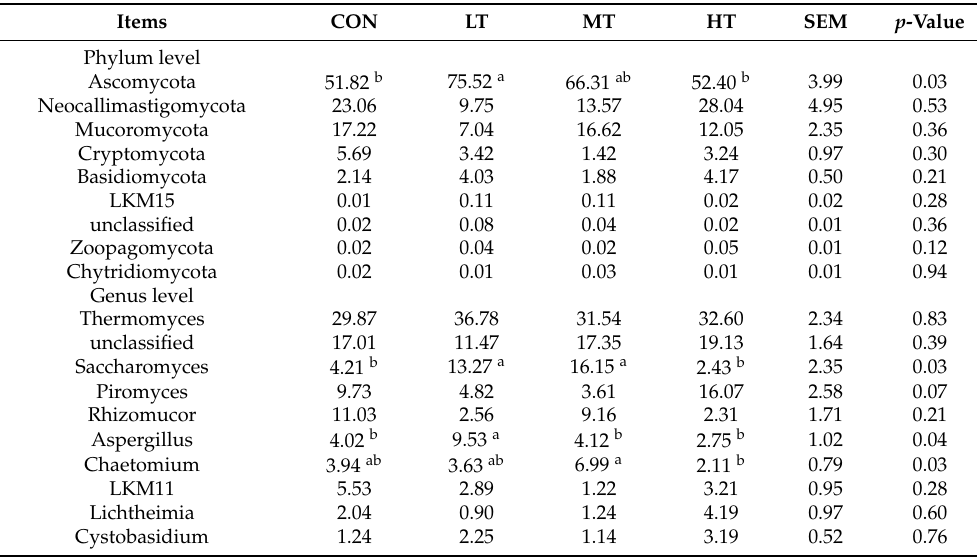
Figure 3. Distribution of fungal taxa averaged under phyla ( A ) and genera ( B ) level across the different treatment groups (as a percentage of the total sequence). Table 6. Species and relative abundance of ruminal fluid fungi in cattle at phylum level and genus